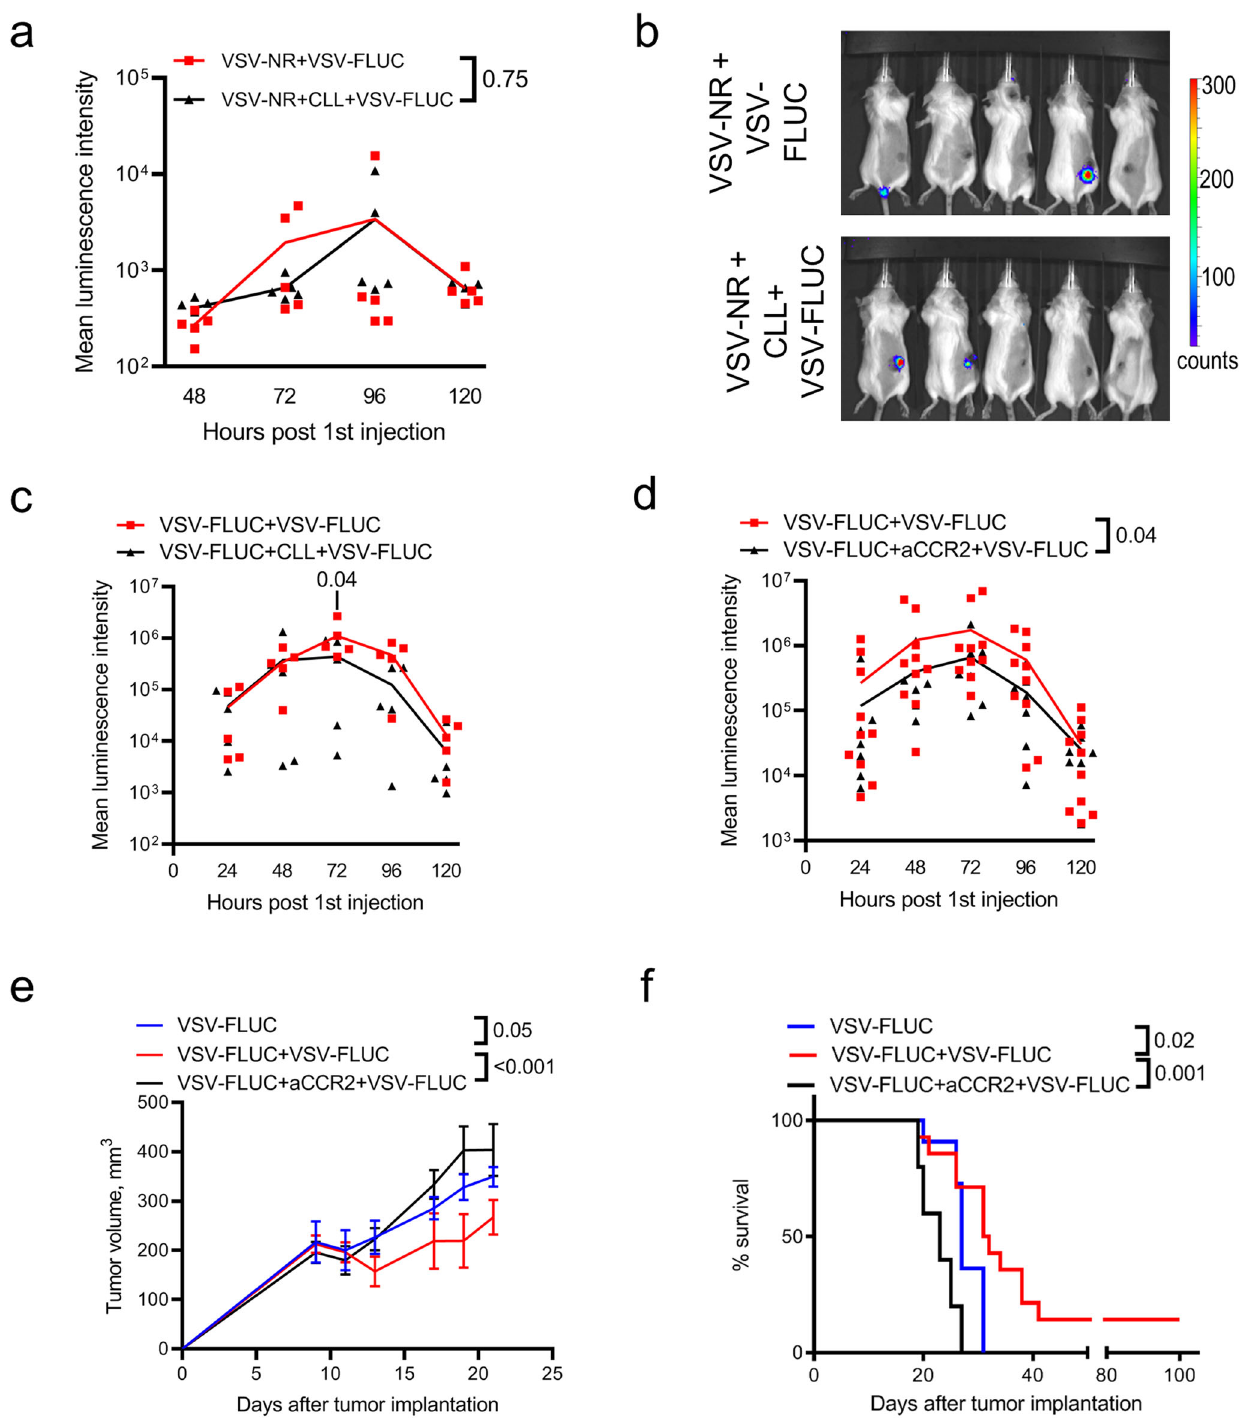
Fig. 3 Interactions between OV and in fl ammatory monocytes promote better infection of the initial OV dose. a Luminescence intensity for CT26 LacZ tumors during a 2-dose OVT schedule (10 6 PFU) with or without CLL treatment 24 h after the fi rst virus administration. VSV-FLUC was administered as a second dose 48 h after initial treatment with VSV-NR. Results are shown as mean with individual values ( n = 5); two-way ANOVA. b Bioluminescence images for the groups shown in ( a ) 48 h after administration of the second dose of VSV. c , d Luminescence intensities for CT26 LacZ tumors during a 2 dose OVT schedule (10 6 PFU VSV-FLUC, 48 h between doses) with or without monocyte depletion by CLL ( c ) or anti-CCR2 antibody ( d ) administered between viral doses. Results are shown as mean with individual values ( n = 5 ( c ); n = 7 ( d )); two-way ANOVA. e Tumor measurements for CT26 LacZ -bearing mice treated with one or two doses of VSV-FLUC (10 6 PFU, 48 h between i.v. injections) ±anti-CCR2. Results are shown as mean ± SEM ( n = 5); two-way ANOVA followed by Sidak ’ s multiple comparisons test. f Kaplan – Meier survival plots for animals treated with one or two doses of VSV-FLUC ± anti-CCR2; log-rank